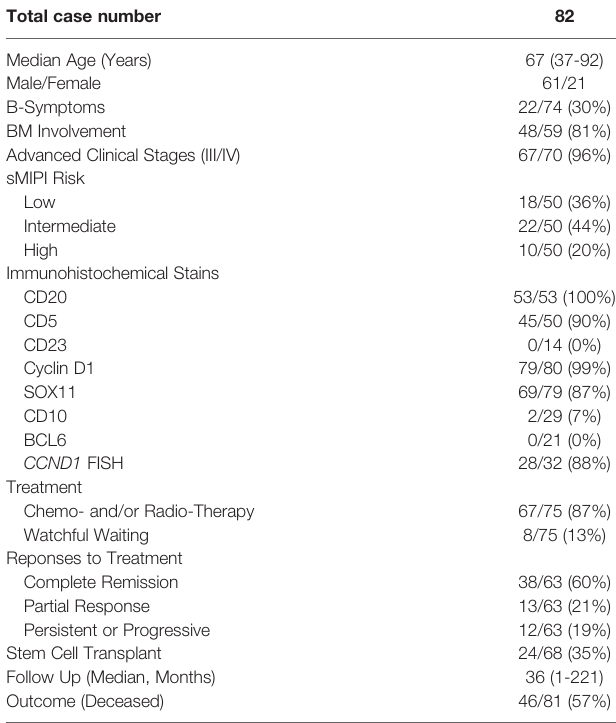
TABLE 1 | Summary of the clinicopathologic data of the 82 patients with